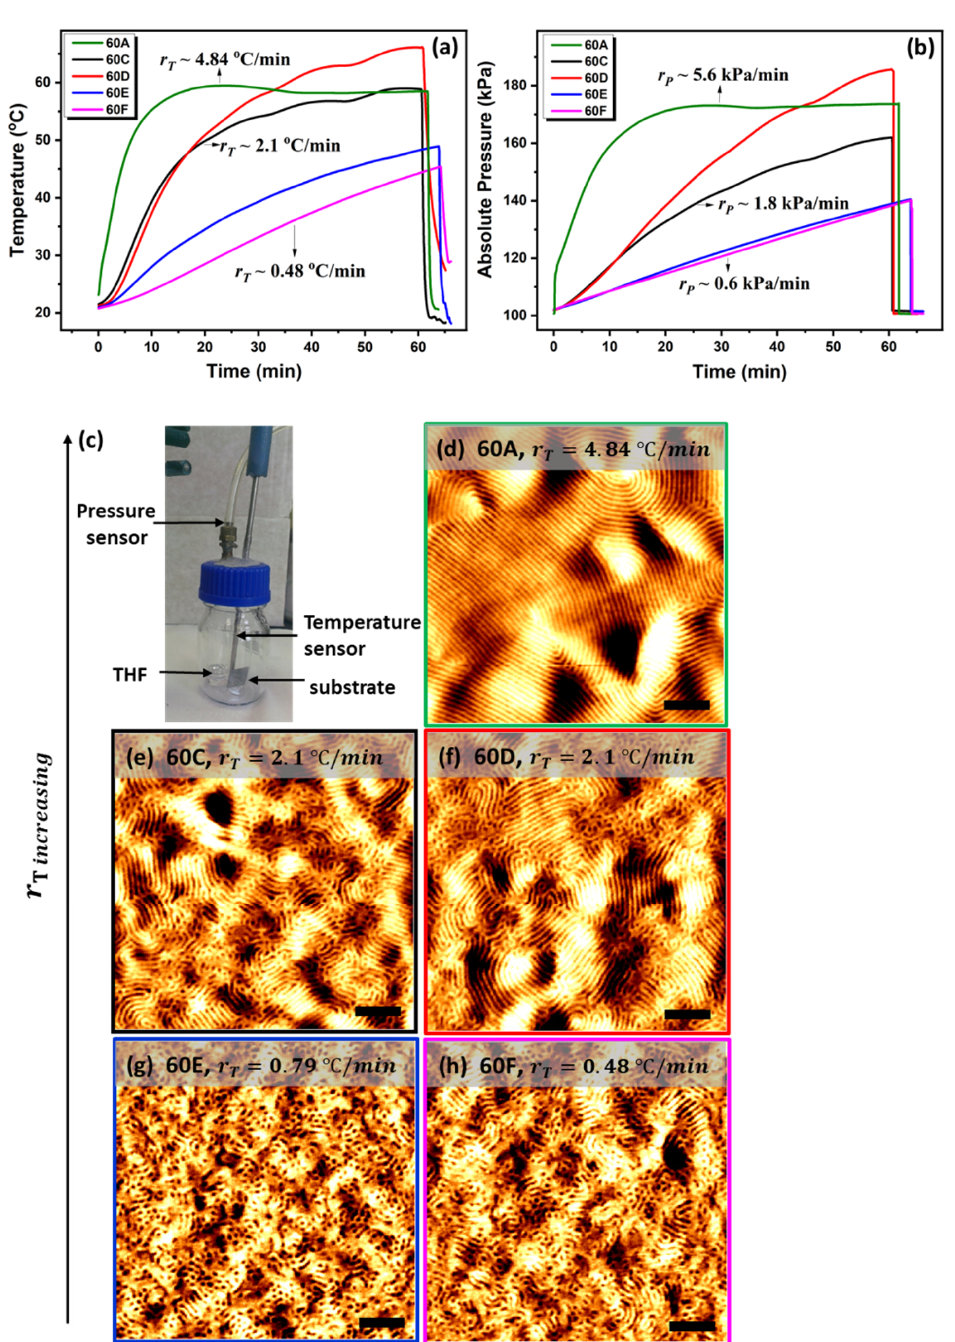
Figure 2. ( a ) Temperature and ( b ) absolute vapour pressure profiles for the films annealed in oven at different temperature ramps for 60 min. Higher temperature ramp leads to higher degree of order. AFM images (scale bars 300 nm) show high coherence length for ( d ) high heating ramp ( r T ∼ 4.84 ◦ C/min , sample 60A); moderate phase separation for ( e , f ) medium heating ramp ( r T ∼ 2.1 ◦ C/min, samples 60C and 60D); poor phase separation for ( g , h ) low heating ramp ( r T ≤ 0.76 ◦ C/min, samples 60E and 60F). Image ( c ) shows the annealing jar with temperature and pressure